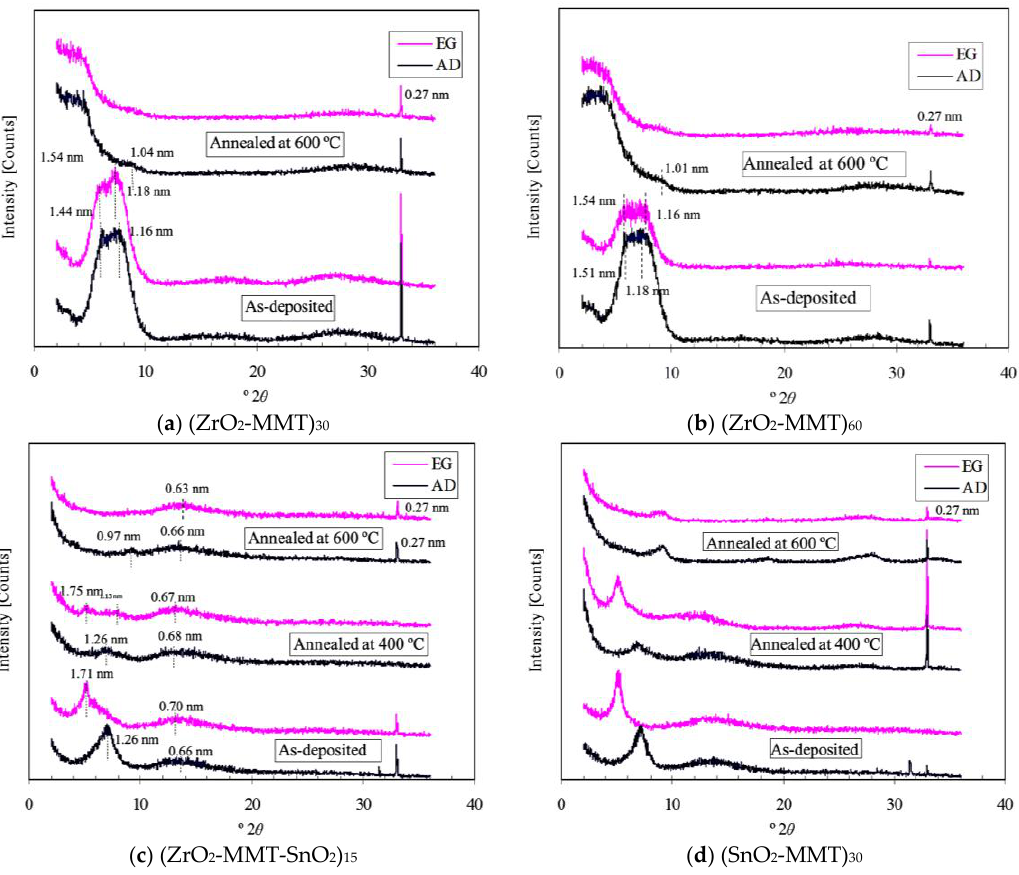
Figure 10. X-ray Diffraction (XRD) patterns of clay-oxide multilayers with clay concentration of 0.40 wt %. ( a ) (ZrO 2 -MMT) 30 with Na-HMP (5 g/L) to exfoliate the clay particles; ( b ) (ZrO 2 -MMT) 60 with Na-HMP (5 g/L) to exfoliate the clay particles; ( c ) (ZrO 2 -MMT-SnO 2 ) 15 ; and ( d ) (SnO 2 -MMT) 30 . The similar XRD patterns of (ZrO 2 -MMT) 30 and (ZrO 2 -MMT) 60 under as-deposited and annealed at